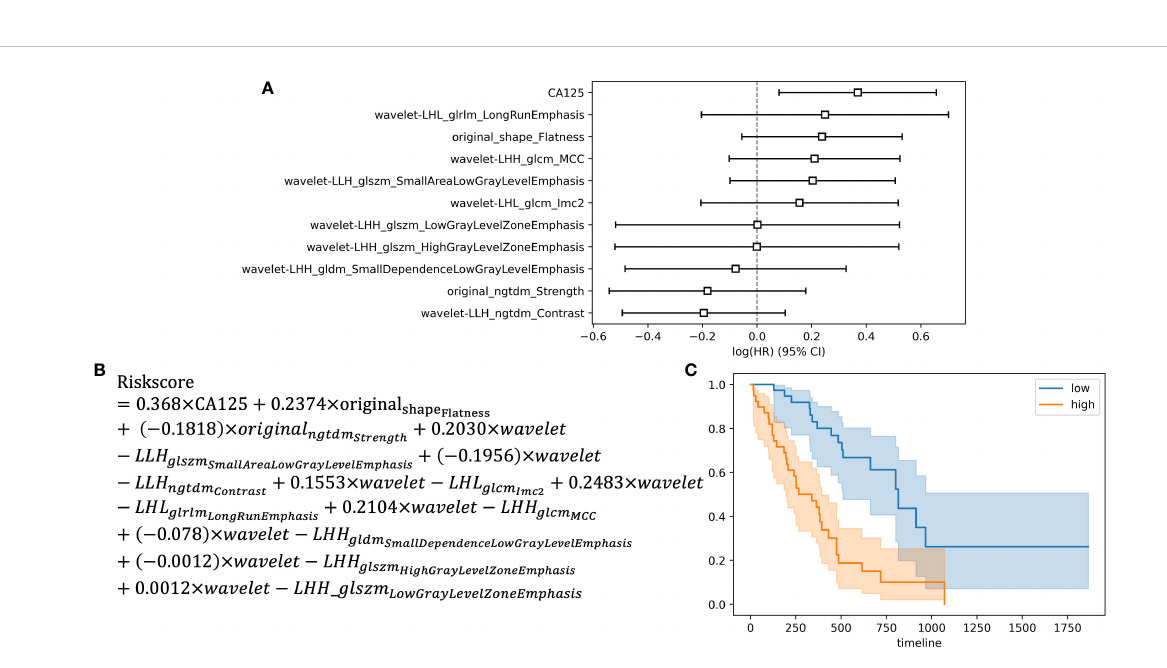
FIGURE 2 Development of the risk score and Kaplan-Meier survival analysis based on the risk score. (A) Forest plot showing hazard ratios for selected features. (B) Development of the risk score. (C) Kaplan-Meier survival curves for the patients in high risk group and low risk group.